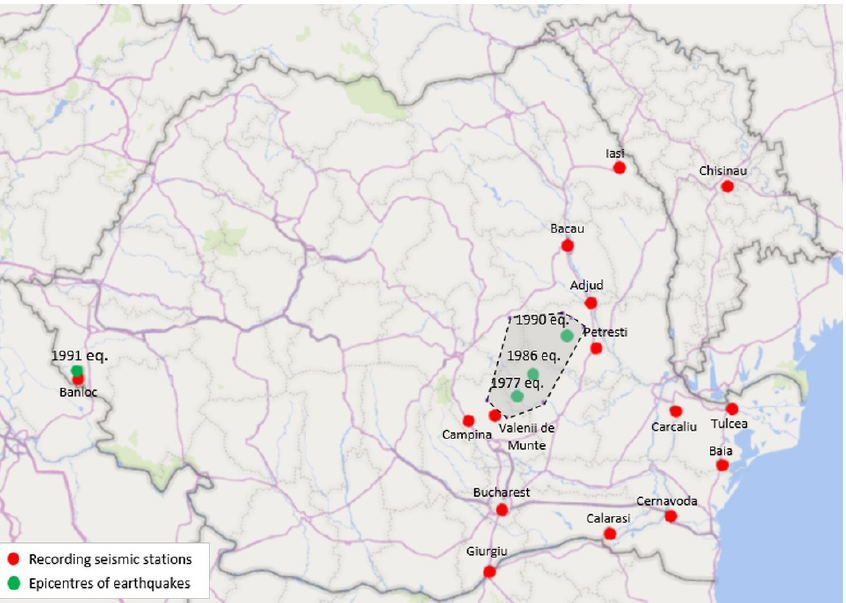
Figure 1. The positions of the 15 analysed seismic stations and of the epicentres of the earthquakes for which ground motion recordings were available. The contour of the Vrancea intermediate-depth seismic source, as defined in the BIGSEES project [25], is also illustrated with the dashed line.